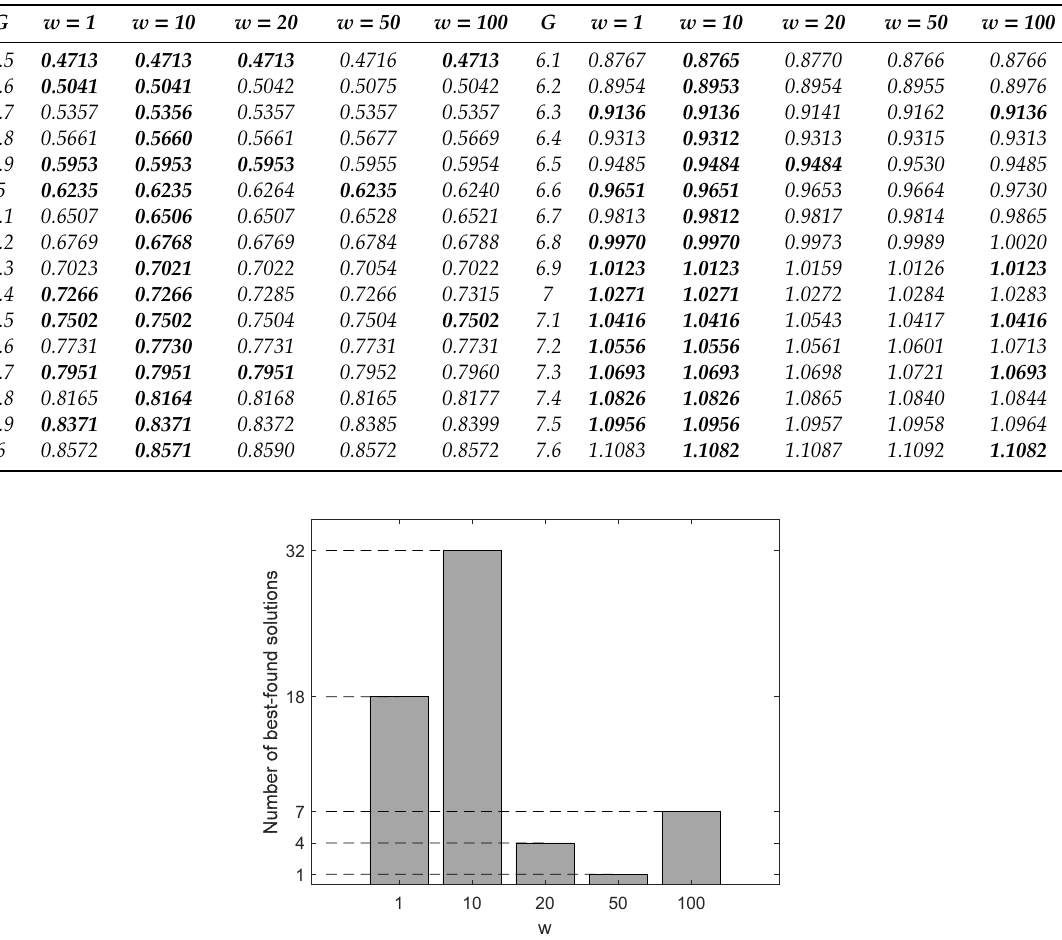
Table 3. Comparative table of the obtained results using di ff erent values for the factor w .